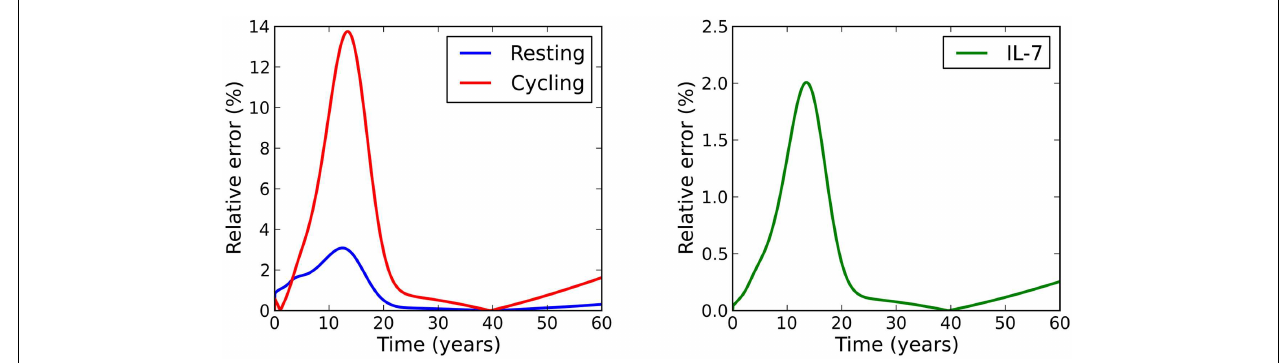
FIGURE 3 | Relative error between the adiabatic solution and the exact solution, where initial conditions were chosen to be equal to the adiabatic solution at time t = 0 .